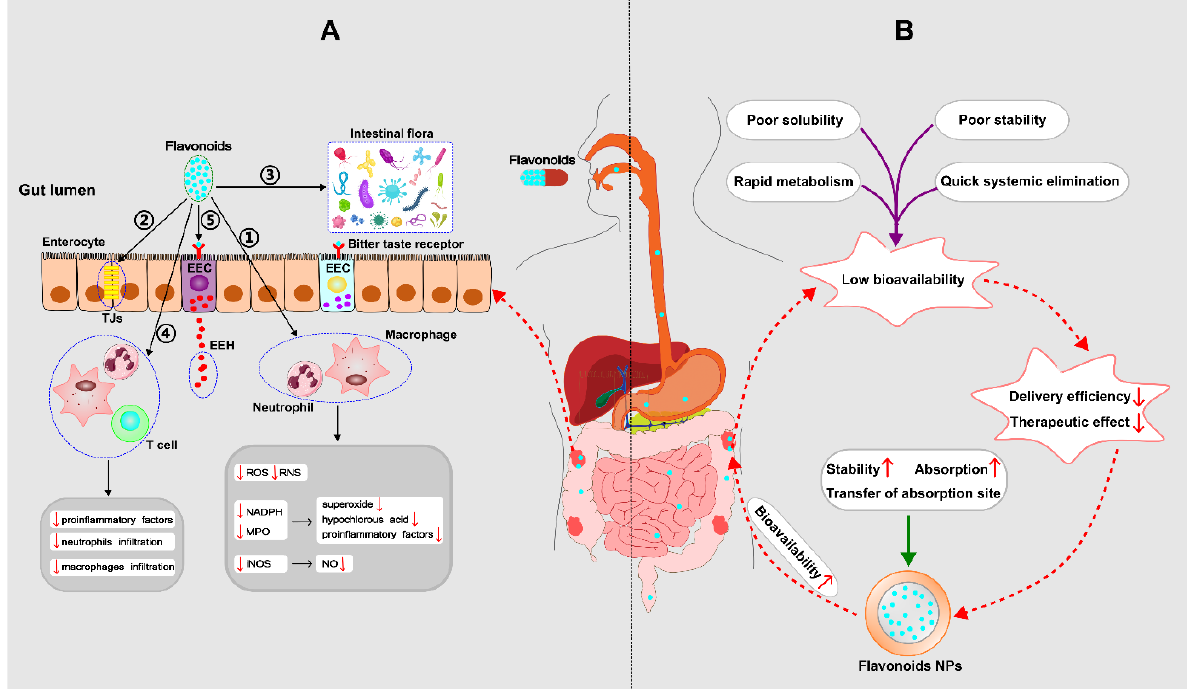
Figure 3. ( A ) Mechanisms by which flavonoids regulate IBD –– ① Antioxidant property; ② Preser- vation of the impaired epithelial barrier: flavonoids have the ability to increase mucus, improve tight junctions (TJs) and the ultrastructure of the intestinal mucosa; ③ Shaping of the